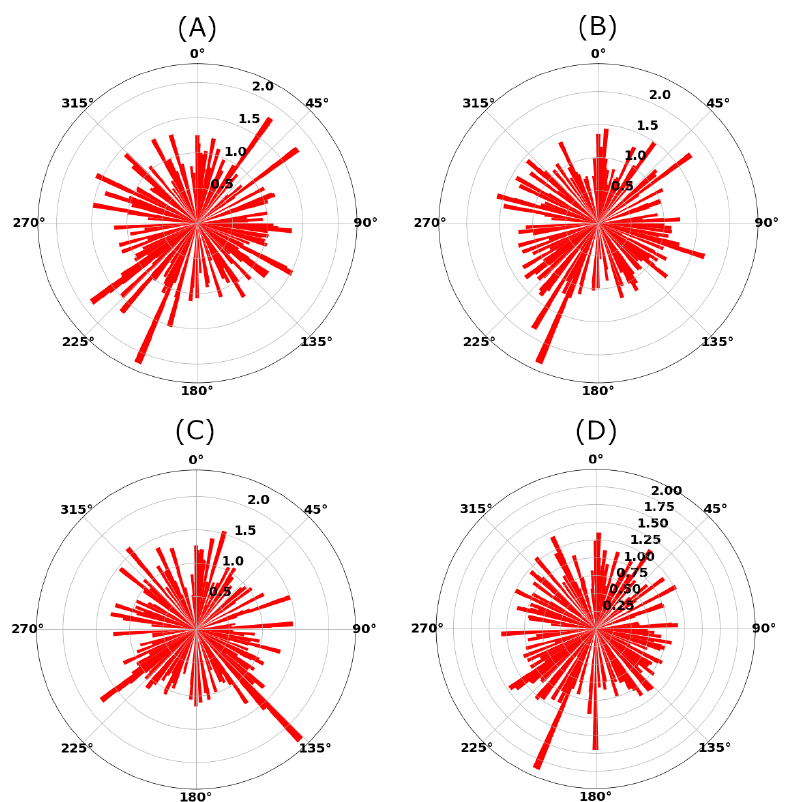
Figure 5. Rose diagrams of amplitude ratios for frequency bands: ( A ) 0.05–0.2 Hz, ( B ) 0.2–0.4 Hz, ( C ) 0.4–0.8 Hz, and ( D ) 0.05–0.8 Hz. The rose diagrams serve as proxy for the azimuthal distribution of noise